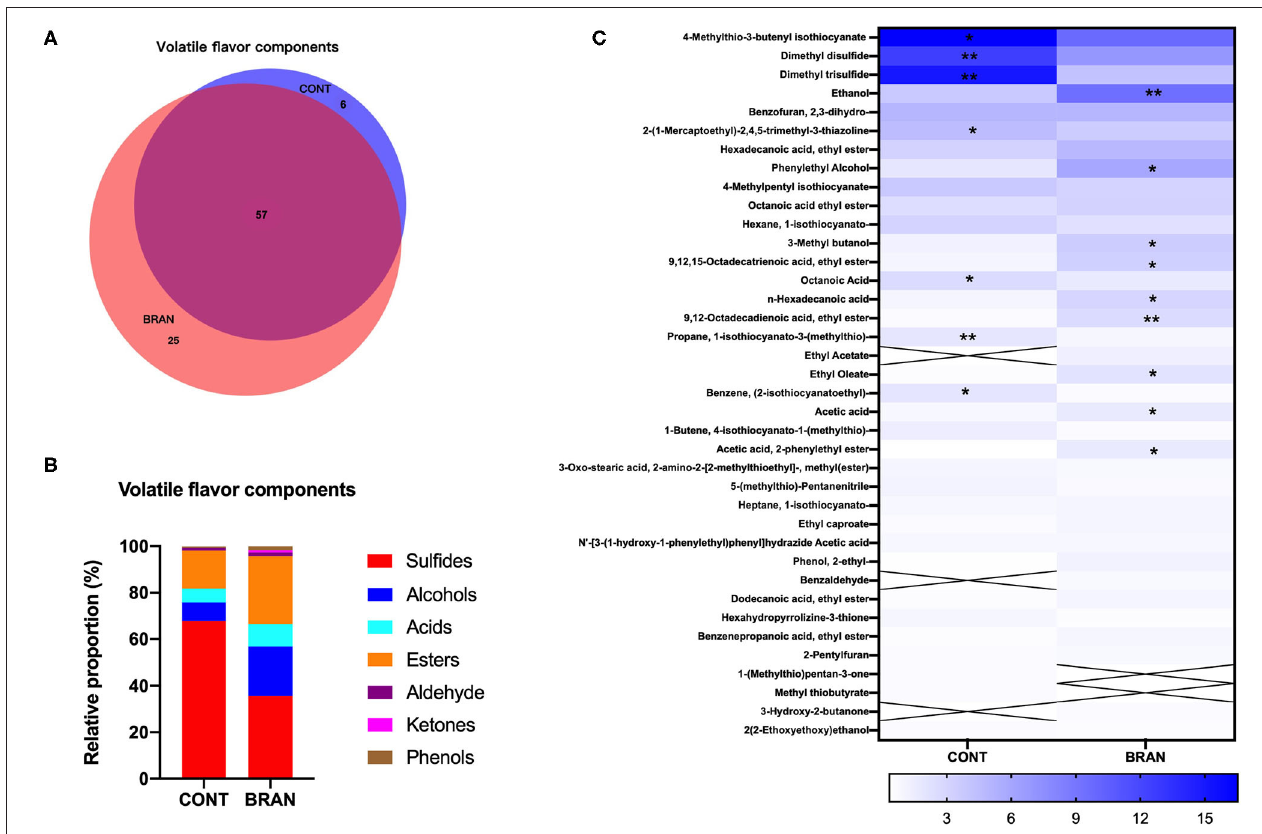
FIGURE 4 | Effect of wheat bran on VF compounds of the ripe pickled radishes on day 28, showing the VEEN analysis of the shared volatiles in the CONT and BRAN groups (A) , relative proportions of volatile categories in the CONT and BRAN groups (B) , and heatmap of relative volatile abundance ( > 0.5%) of the ripe pickled radishes on day 28 (C) . Significant differences within each volatile value between CONT and BRAN are marked as * p < 0.05, ** p <